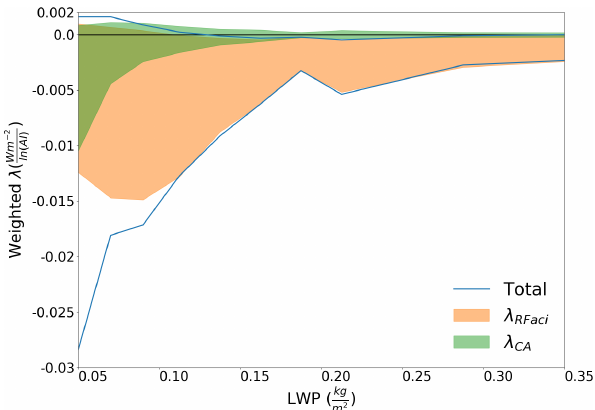
Figure 4. 10% to 90% range of the decomposition for 11 cloud states when found within 100 environmental regimes of EIS and RH 700 . The RFaci warm (orange fill, λ RFaci ) and cloud adjustment susceptibilities (green fill, λ CA ) total − 4 . 18Wm − 2 ln(AI) − 1 and − 1 . 26Wm − 2 ln(AI) − 1 , respectively. The sum of the two from 10 to 90 percentiles, the decomposed susceptibility (blue line), totals − 5 . 45Wm − 2 ln(AI) − 1